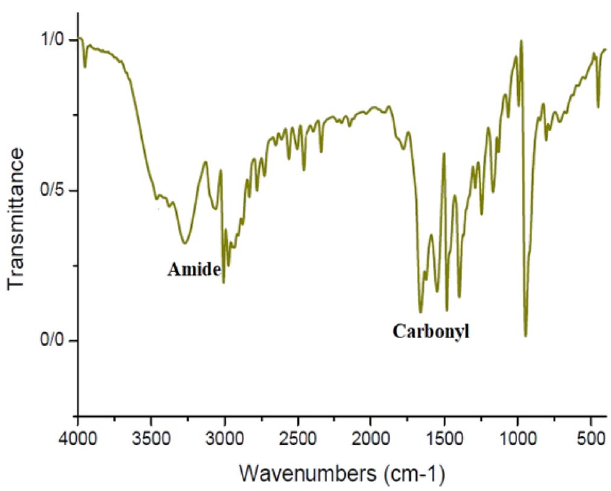
Figure 14. IR spectrum of cPNIPAAM produced in homogeneous phase of SC-CO 2 and DMF